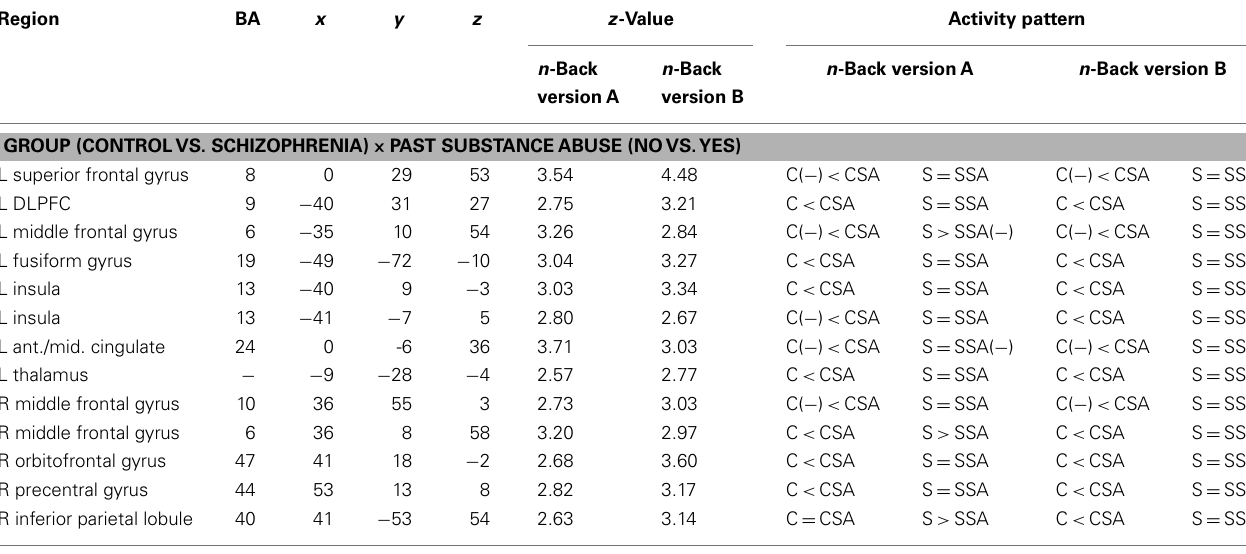
Table 5 | Brain regions displaying a significant interaction between diagnostic group and past substance abuse during both versions of the n -back .